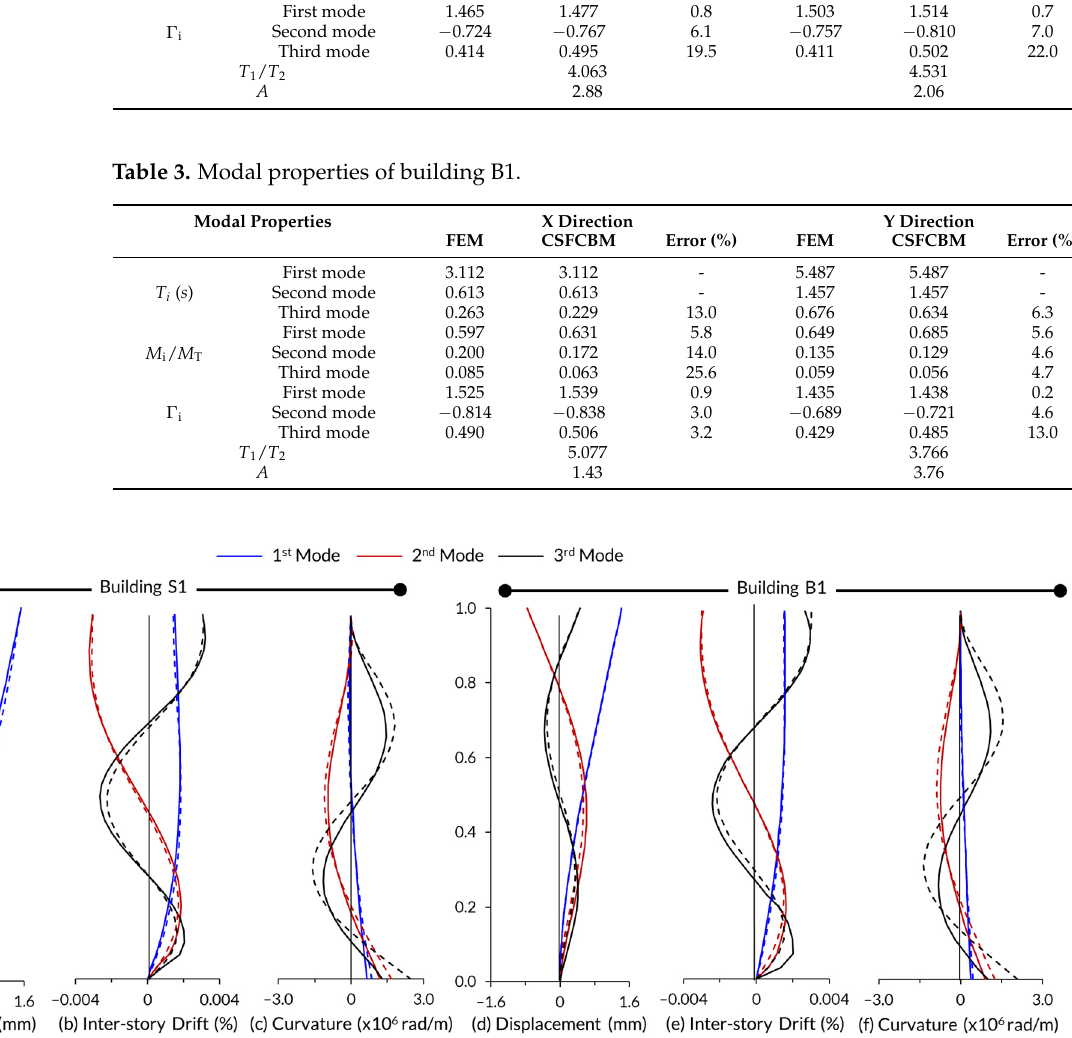
Figure 4. Deformation responses of buildings S1 and B1 in the x direction.